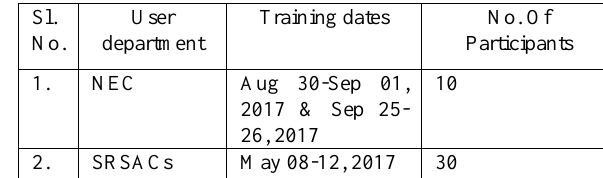
Figure 5: Participants during UAV training at NESAC Sl.